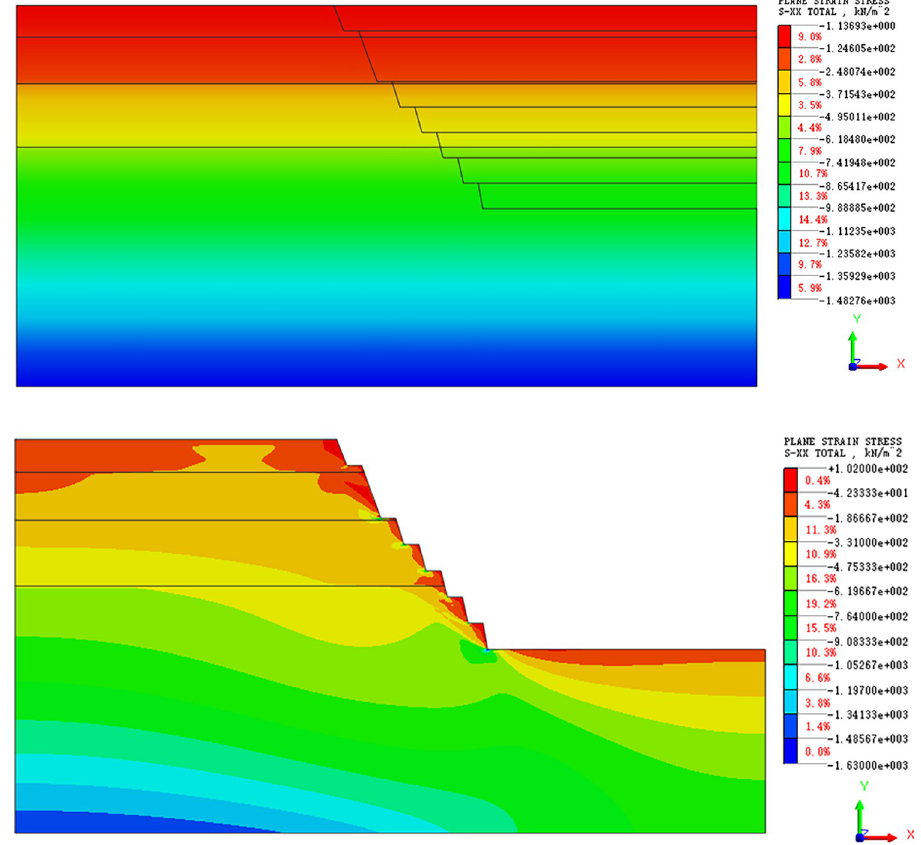
Fig 7. (a). Horizontal stress cloud map (initial stress equilibrium). (b). Horizontal stress cloud map (excavation